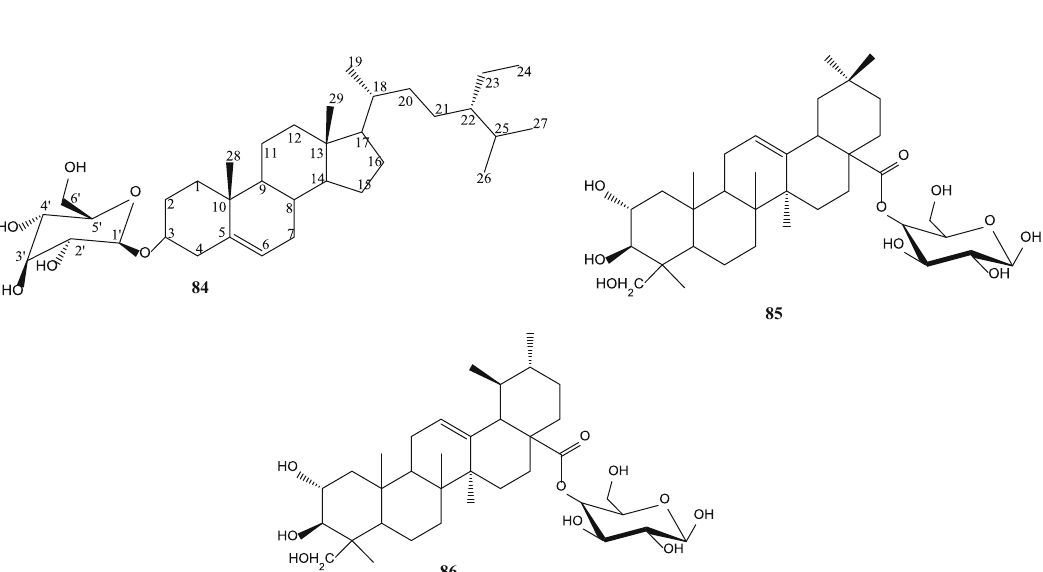
Figure 5: Steroids from various parts of S. aromaticum and S. cumini .